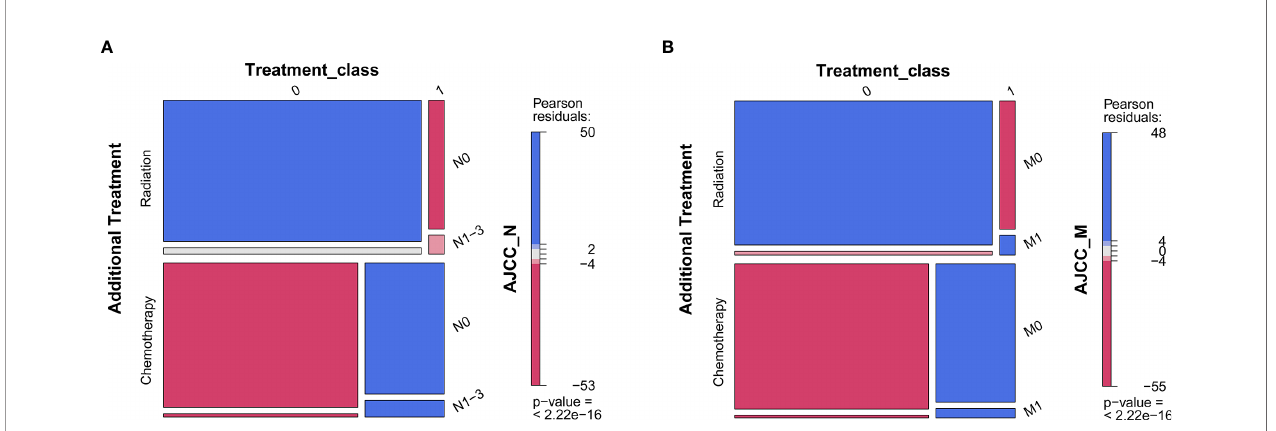
FIGURE 3 | Mosaic plot for describing interaction among additional treatment, treatment class, and AJCC stages. (A) AJCC_N stage; (B) AJCC_M stage. P < 0.05 indicates interaction between variables. The blue tiles represent more frequency than expected in the null model, while red tiles represent less frequency than expected.